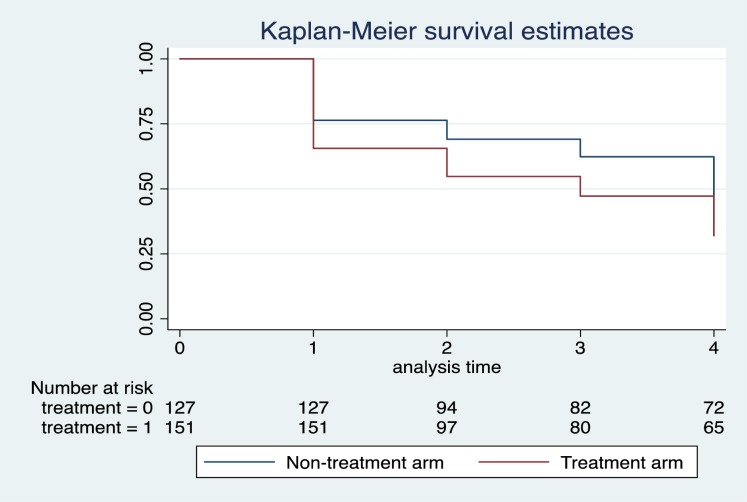
Kaplan-Meier survival estimates.